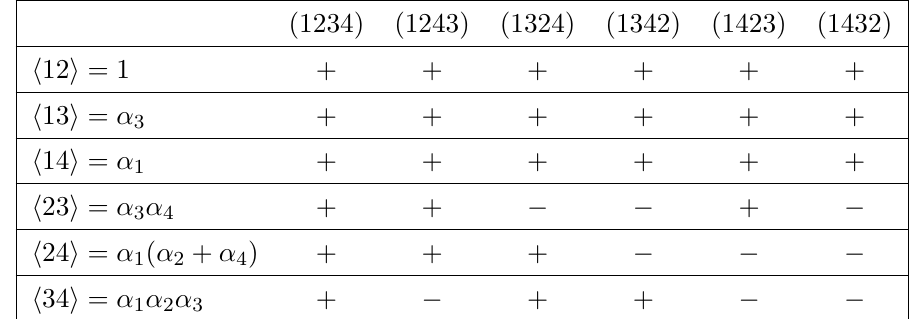
for each ordering σ ∈ O 4 , 2